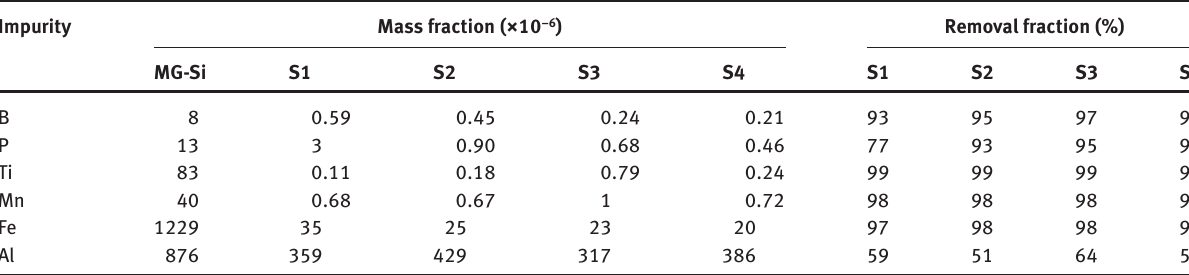
Table 1: Impurities content of refined Si and removal fractions after purification Impurity